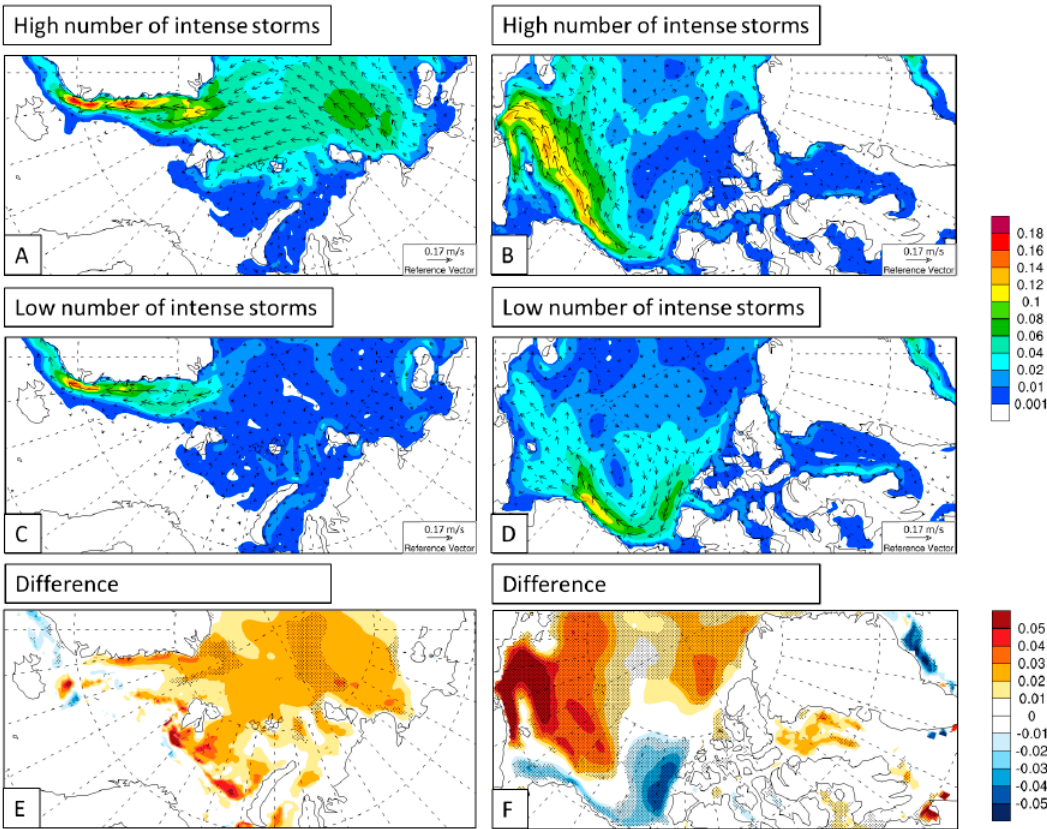
Figure 6. The same as Figure 4 but for sea ice drift (unit: (m/s)). The magnitude of sea ice drift speed is shaded in color. ( a ), ( c ), and ( e ) show the composite analysis results in the Atlantic Arctic Ocean and ( b ), ( d ), and ( f ) show those in the Pacific Arctic Ocean region specifically.